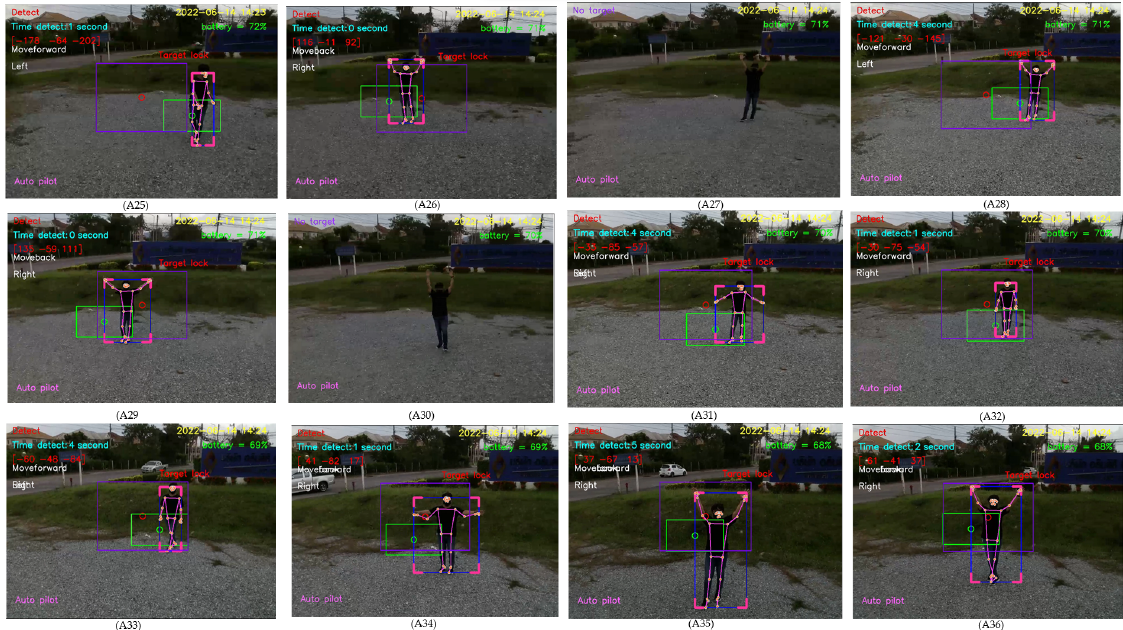
Figure 36. Sampling frames 61–87 of automatic tracking human